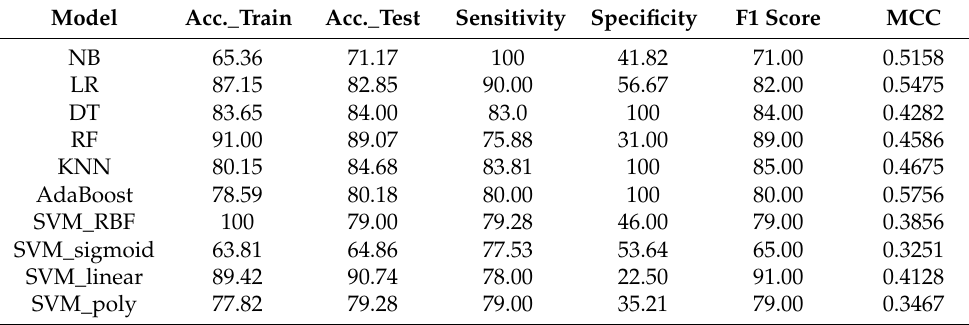
Table 3. Performances of ML models on balance data using all